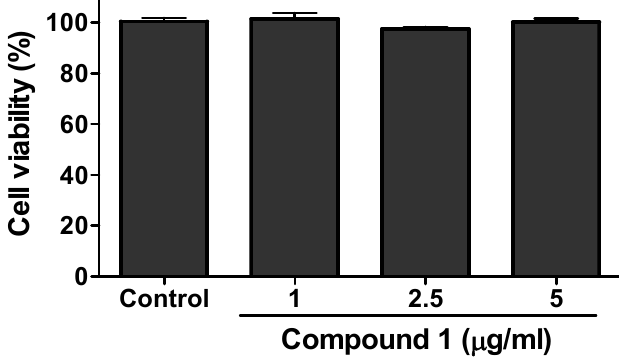
Figure 7. RAW cells viability assay of compound 1 . Raw cells were cultured and seeded in 96 ‐ well plate. After more than 80% confluence, the cells were treated with different concentration of compound 1 and cell viability was determined using MTT ‐ assay. The data show relative mean expression ± SD of triplicate experiments.